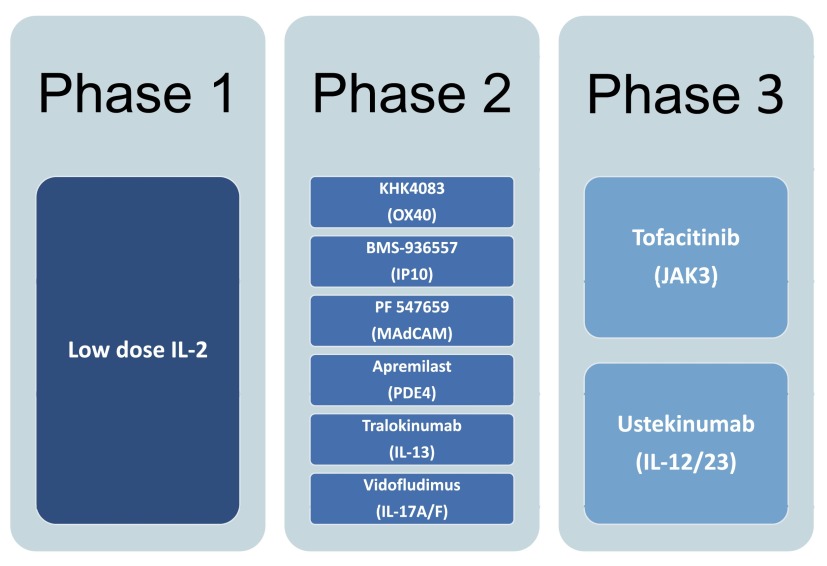
New therapeutic agents for ulcerative colitis.New therapeutic agents for ulcerative colitis with drug targets in parenthesis
47,
83–
90.